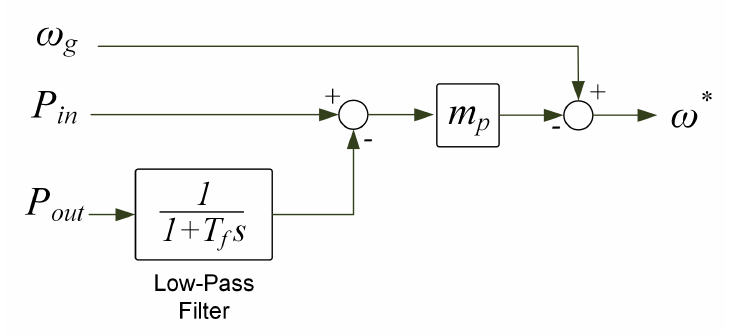
Figure 10. Schematic for frequency droop